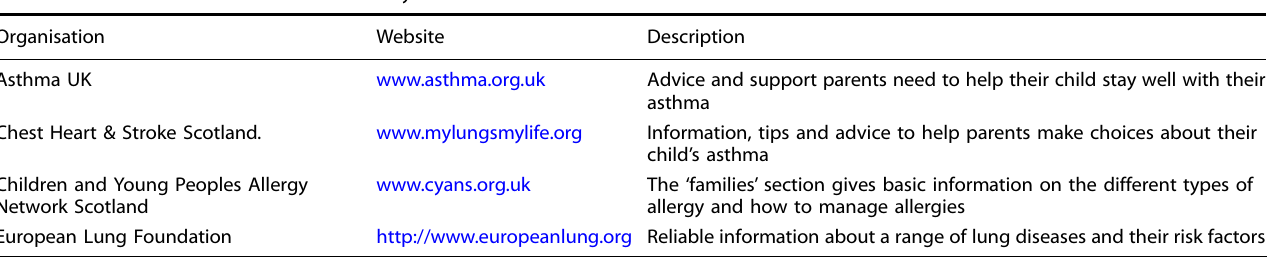
Table 4. Useful websites for families of wheezy